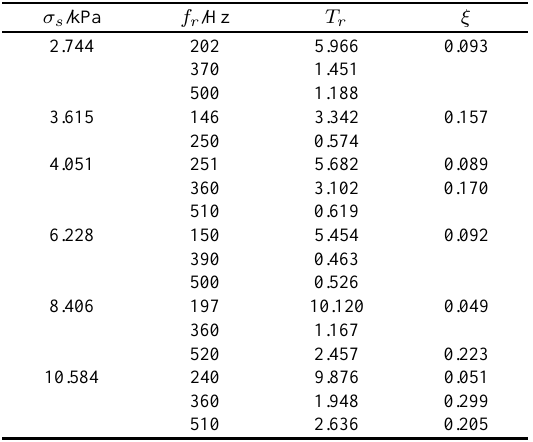
Table 3 Vibration transmissibility of honeycomb paperboard ( T = 30 mm)